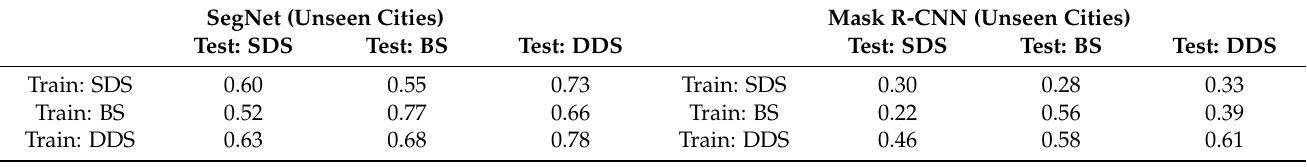
Table 9. Robustness to different building density (RQ6): test set DICE scores of SegNet and Mask R- CNN trained on areas with sparse detached structure (SDS), block structure (BS), and dense detached structure (DDS), respectively. The test data contain cities not seen during training.